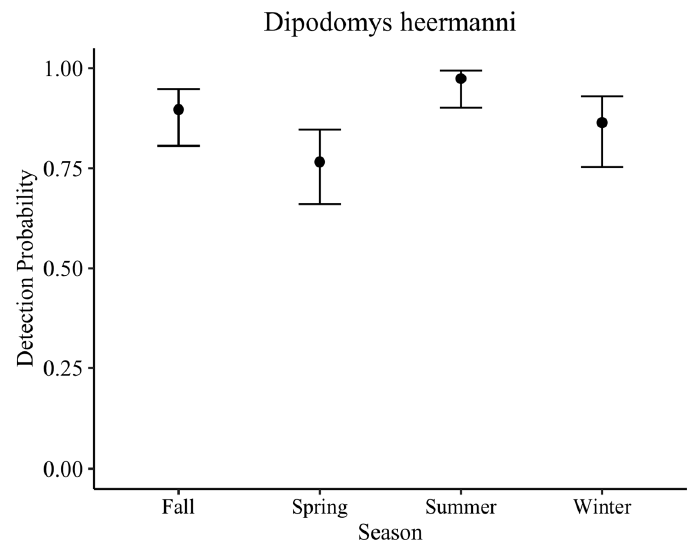
Figure 5. Estimated camera trapping detection probability per night for Dipodomys heermanni across four seasons of deployment obtained using single-season occupancy models [21]. Error bars represent 95% confidence interval. Data was collected from D. h. arenae at ODSVRA using the same camera trapping protocol as was used at the Morro Bay sandspit for MBKR.